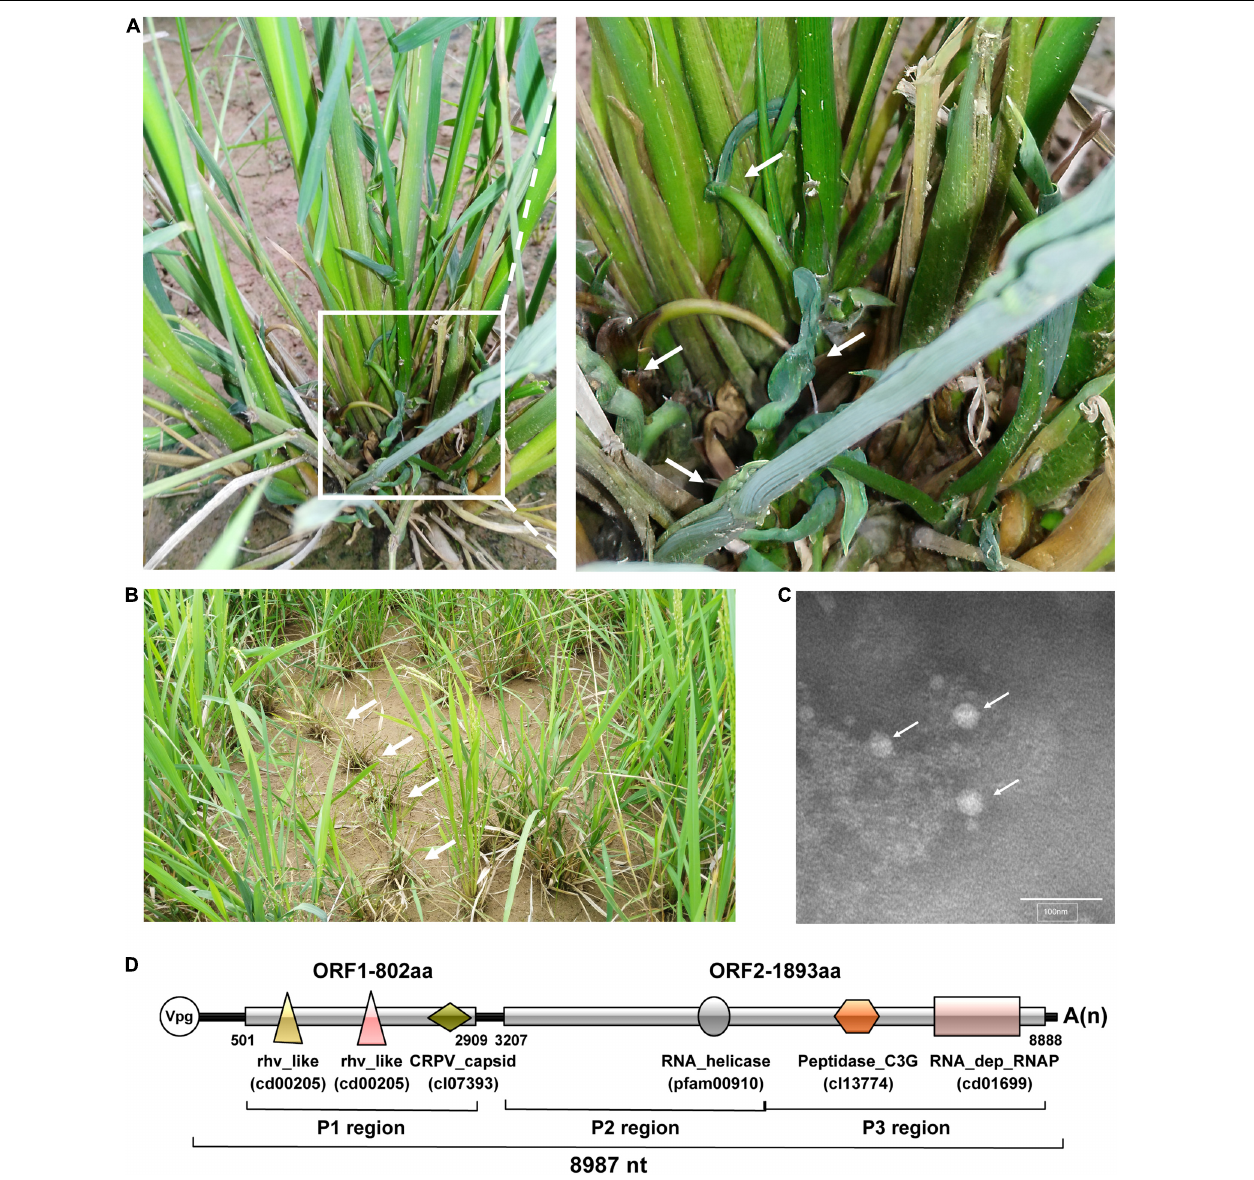
FIGURE 1 | Rice plant symptoms, virions, and genome organization of rice curl dwarf-associated picornavirus (RCDaV). (A) The rice plants showing curling and dwarfing symptoms. The right image is the enlargement of the box in the left image. White arrows indicate curled tilters. (B) The rice plants showing dwarfing in the field. White arrows indicate symptomatic rice plants. (C) Electron micrograph of putative RCDaV virions. Extracts were prepared from curled tilters of rice and examined under a transmission electron microscope after negative staining with a 2% phosphotungstic acid solution, pH 7.0. Bar = 100 nm. White arrows indicate viral particle-like structures. (D) A schematic diagram of RCDaV genome organization. Three protein regions as well as six predicted domains are shown below the diagram. The six different domains are represented by different shapes and colors, and the name of the domains are marked below the shapes. The VPg is a viral protein covalently linked to the 5 (cid:48) end of the viral genomic